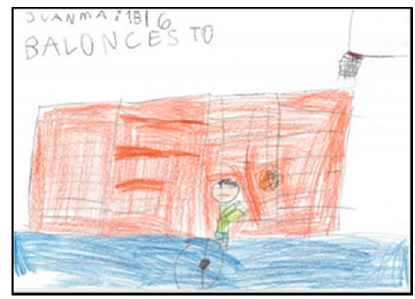
Figure 22. Facial expression. Esteban. 2°B.